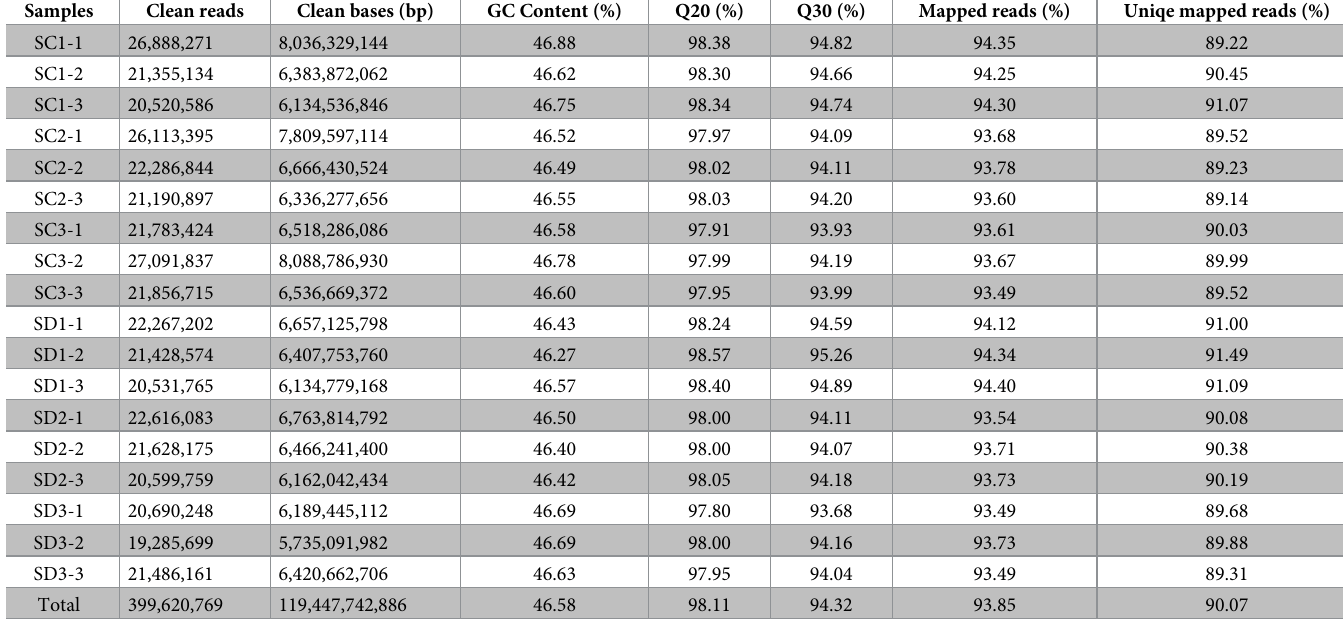
Table 2. Statistics on the quality and